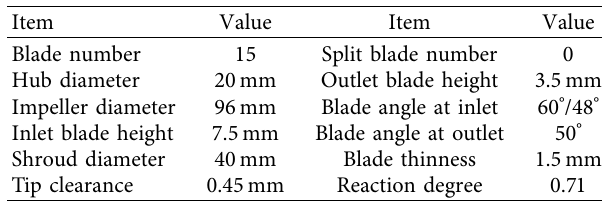
Figure 13: Comparison of numerically predicted results against the SNL experimental data. (a) Revised efficiency and (b) Glassman enthalpy rise. Table 4: Design specification of the IET impeller [32].